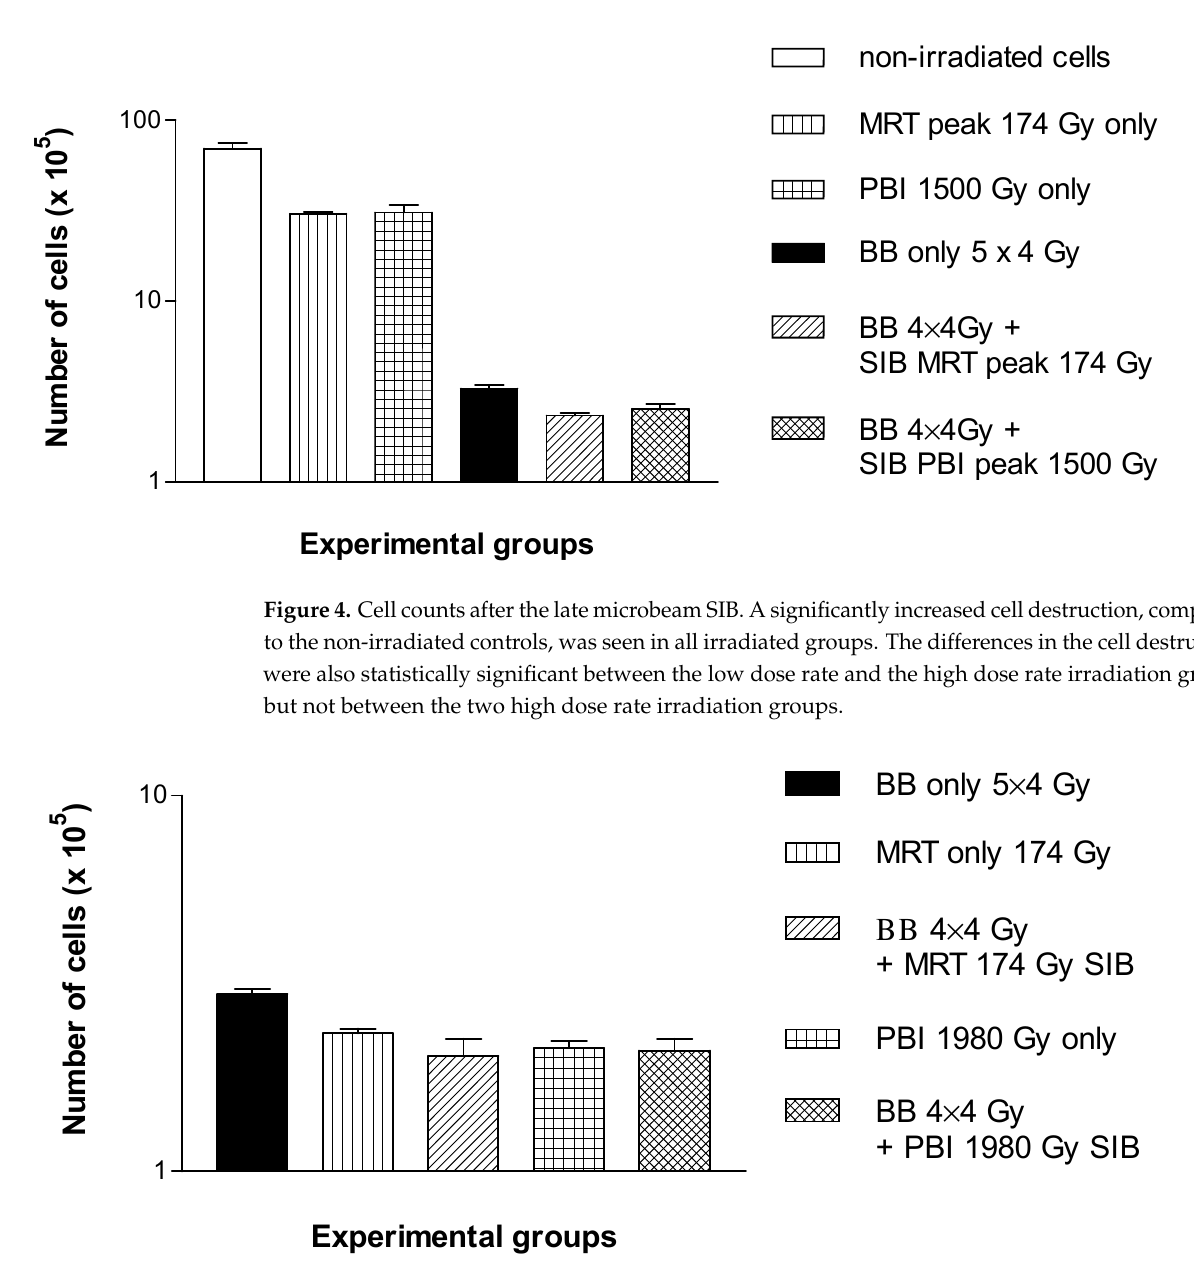
Figure 5. Secondary cell counts (with conditioned medium). Single fraction high dose rate, as well as high dose rate SIBs are significantly more effective than low dose rates only. There was no significant difference between the high dose rate techniques.